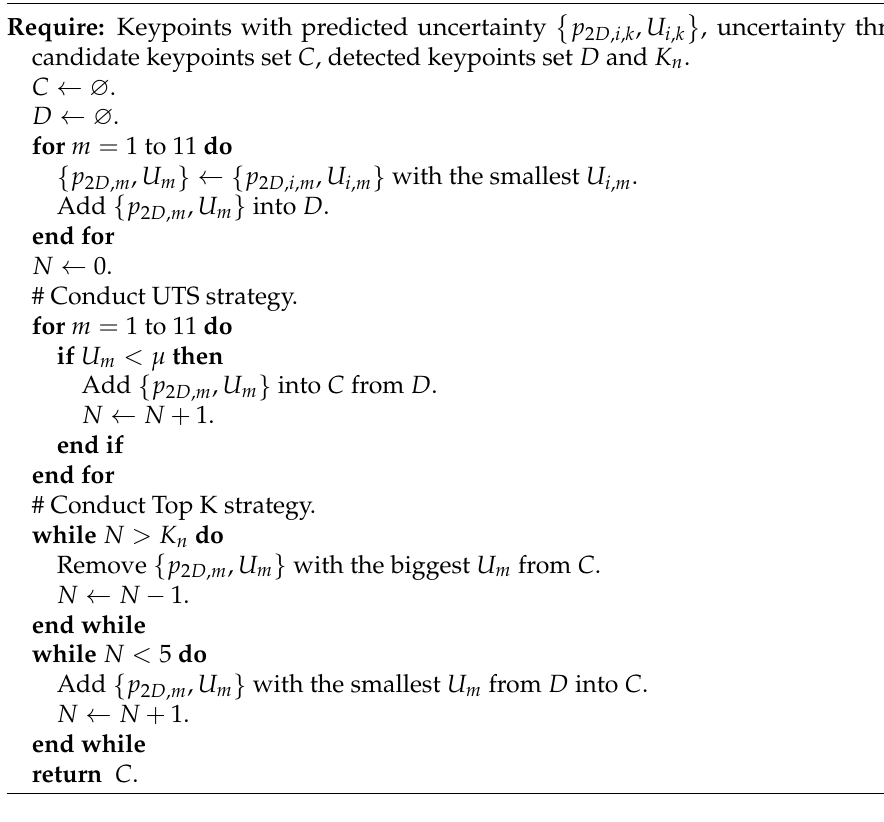
Algorithm 1 Keypoints selection